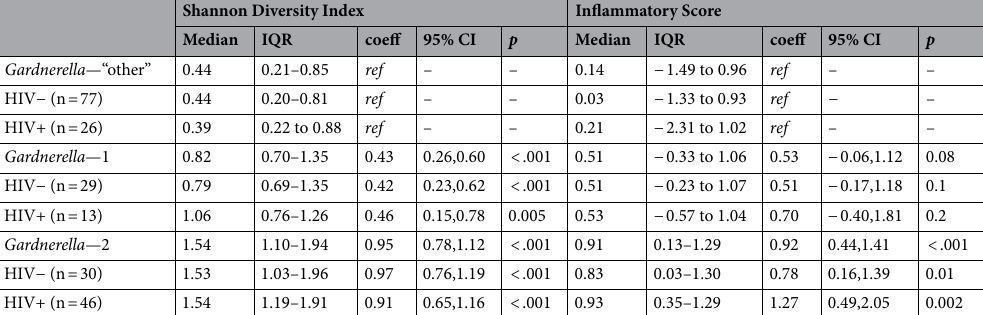
Table 5. Shannon diversity indices and inflammatory scores by Gardnerella metagenomic subspecies at baseline at 16–20 gestational weeks. Coefficients, 95% confidence intervals, and associated p values calculated by weighted linear